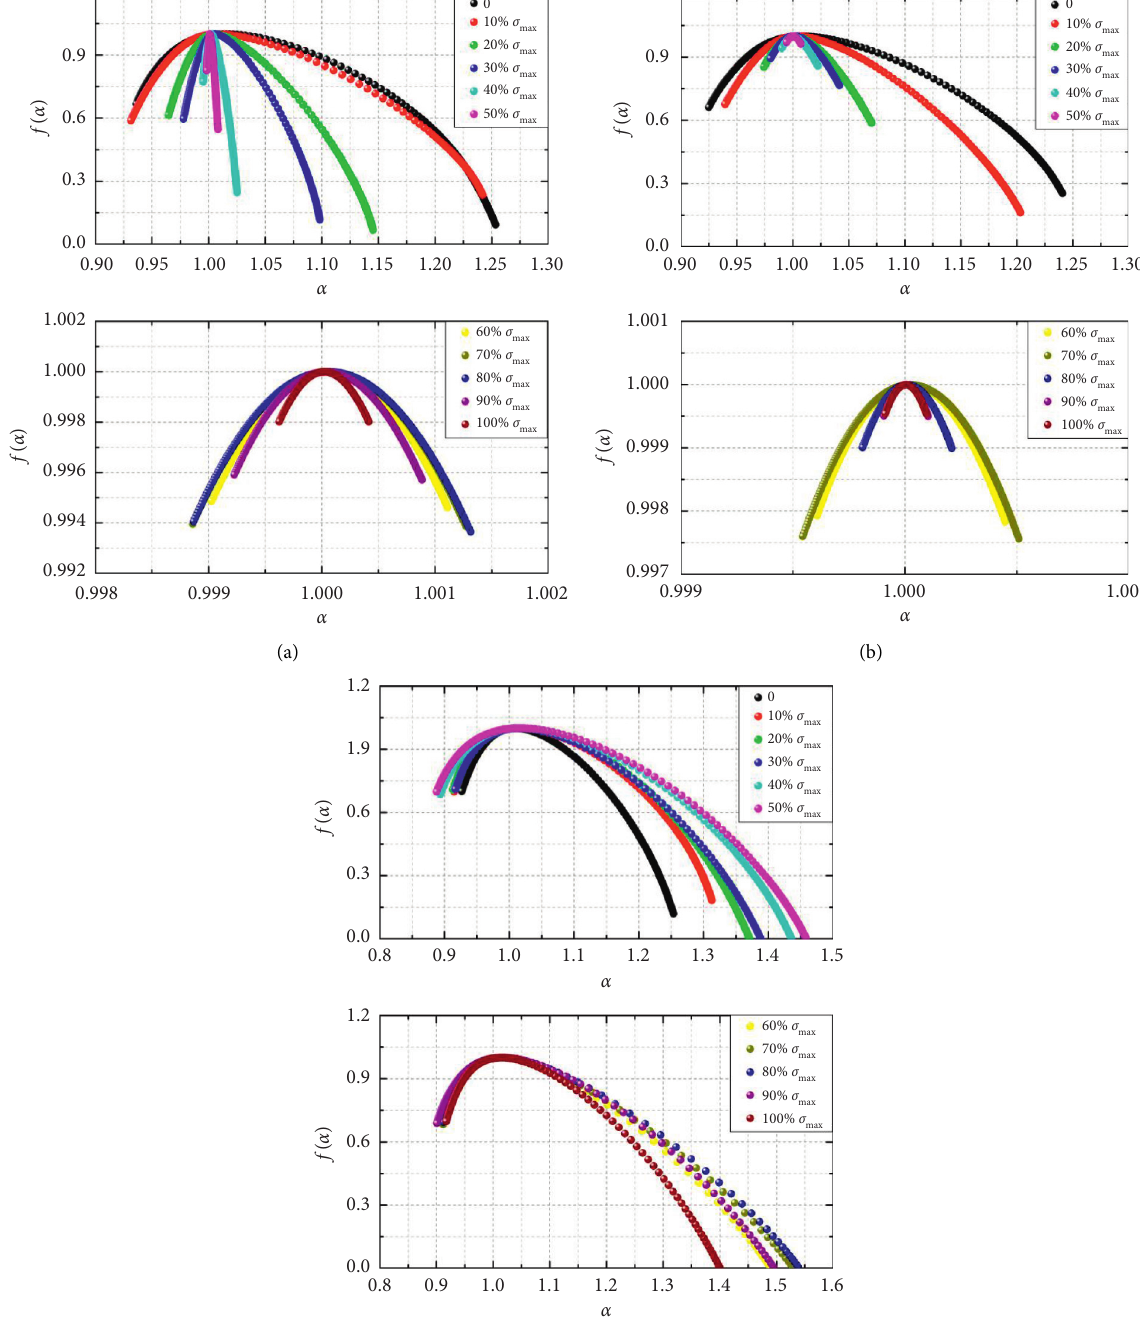
Figure 4: Multifractal spectrum in three orthogonal directions at the different stress stage. (a) X direction. (b) Y direction. (c) Z